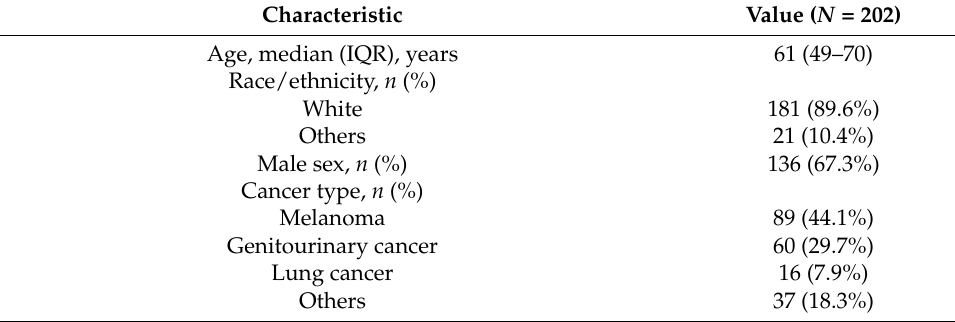
Table 1. Demographic